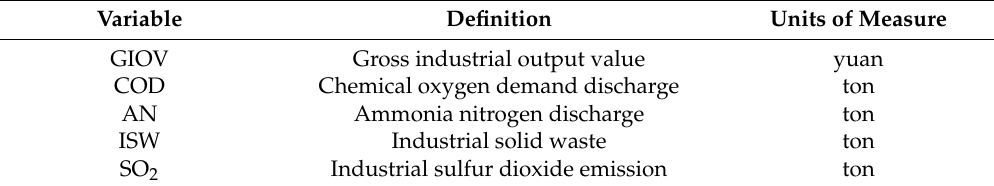
Table 1. Variables used in this study.